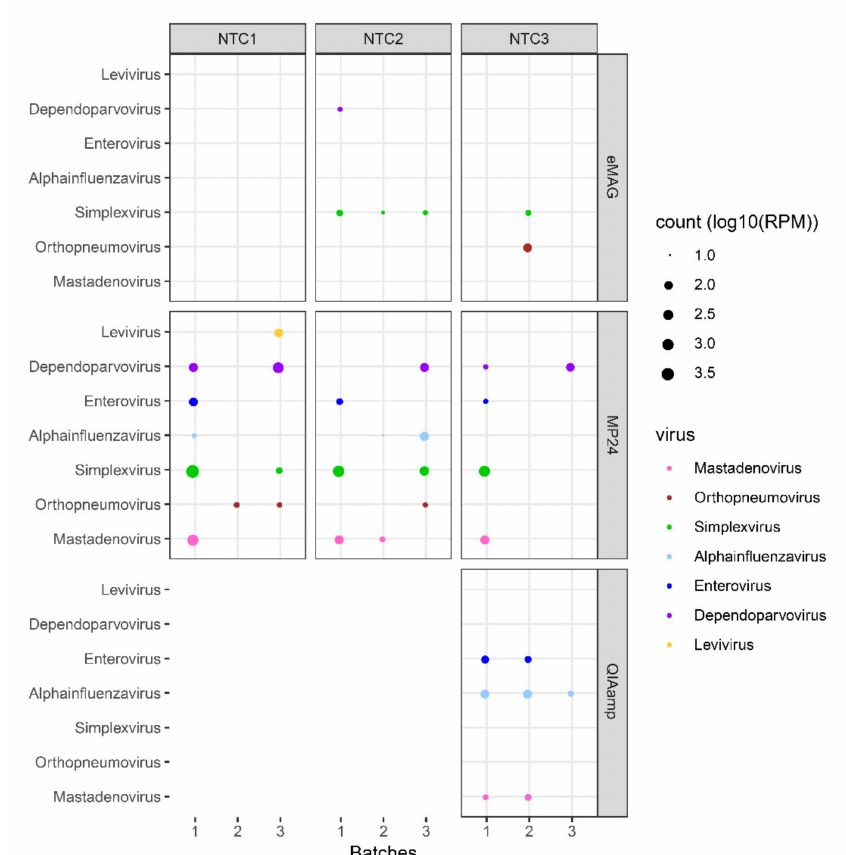
Figure 5. Sample cross-contamination. Bubble plot showing the normalized abundance in log 10 (RPM) of the targeted viruses in each NTC and for the di ff erent extraction methods. During the automated extractions, NTCs were interspersed between samples (i.e., 3 NTCs per batch). For manual extraction, only one NTC was added. Analyses were performed at the genus level. Each genus is represented by coloured dots. The size of the dots represents the abundance normalized in log 10 (RPM) for viral reads associated with sample cross-contamination. HSV: herpes simplex virus; RSV: respiratory syncytial virus; NTC: no template control; RPM: reads per